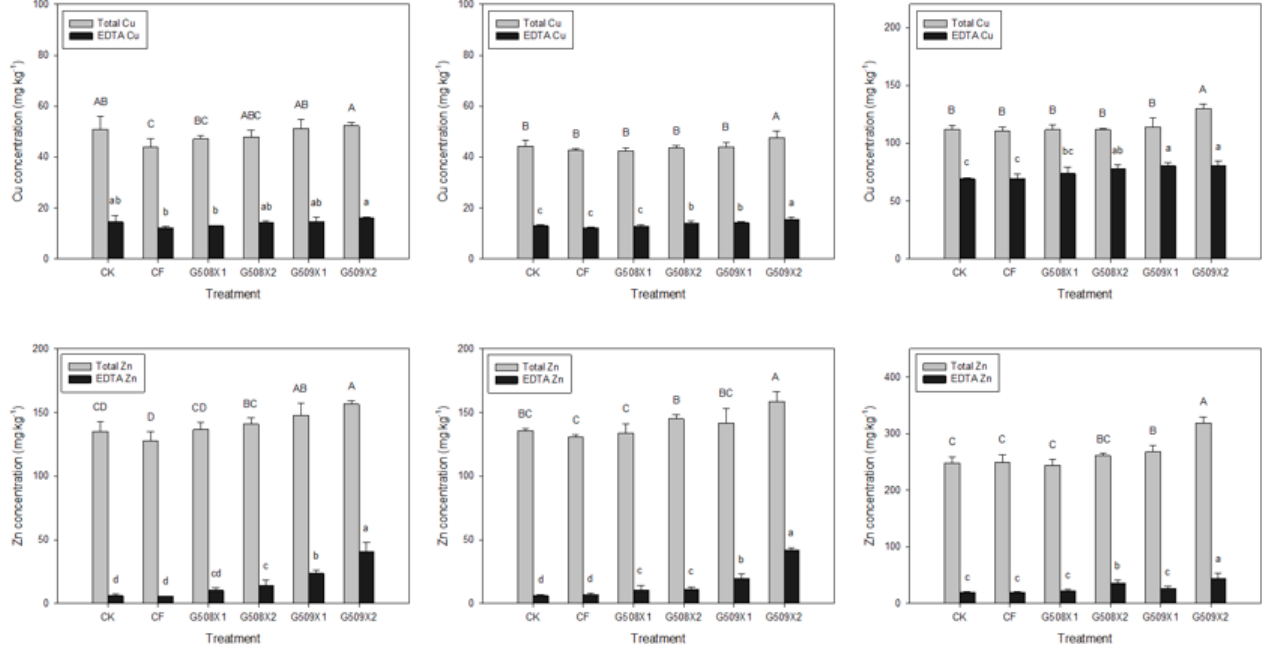
Figure A2. Total and available concentrations of Cu and Zn in the soil under different treatments after the field experiment: cabbage ( left ), Chinese cabbage ( middle ), and water spinach ( right ). The different letters indicate the significance among the treatments obtained through one-way ANOVA analysis (Duncan test, p < 0.05, n = 4). The codes have the same meanings as those in Figure 1.